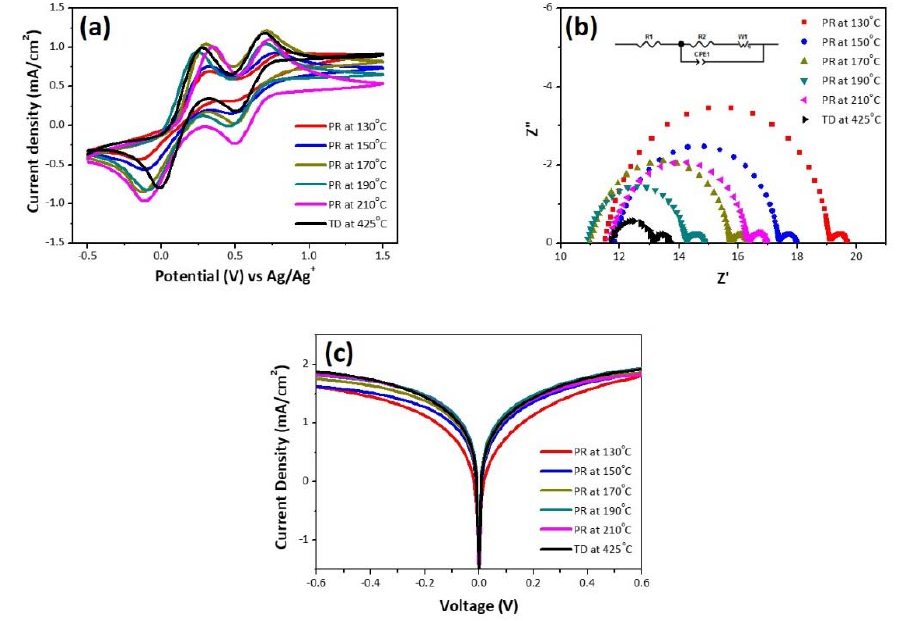
Figure 4. ( a ) Cyclic voltammograms for the redox of (cid:1835) (cid:2871)(cid:2879) /(cid:1835) (cid:2879) species, ( b ) electrochemical impedance spectroscopy (EIS) Nyquist plots for the symmetric cells, and ( c ) Tafel polarization curves.